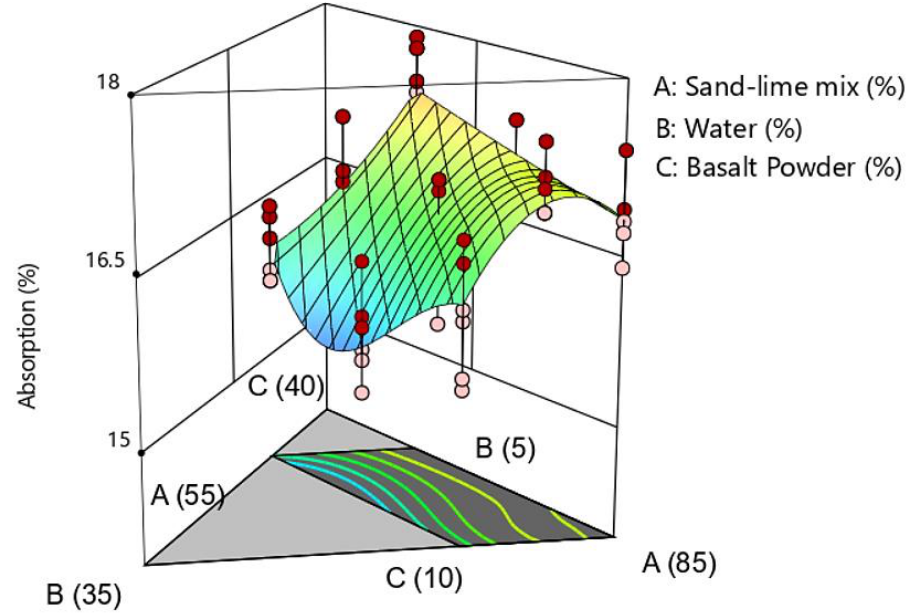
Figure 8. Water absorption of samples.